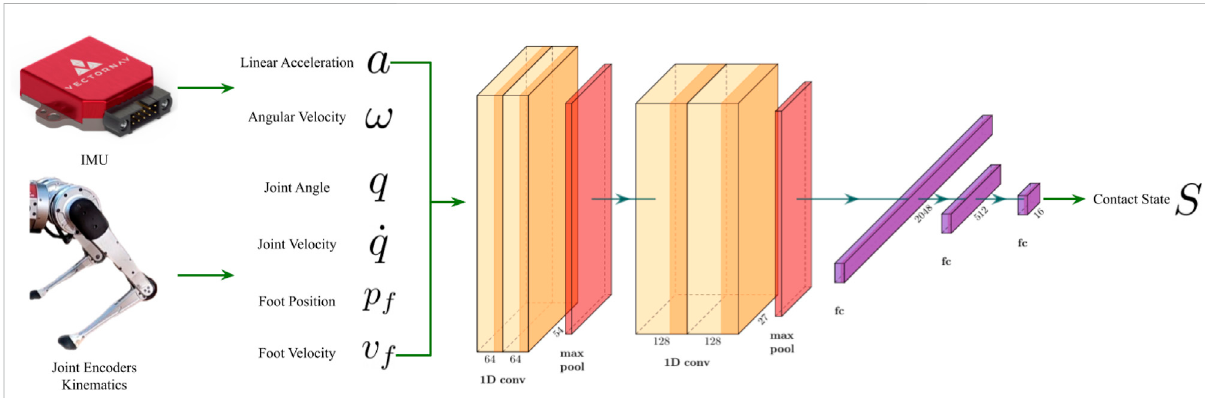
FIGURE 4 Thearchitectureoftheproposedcontactestimator(Linetal.,2022).TheinputsincludelinearaccelerationsandangularvelocitiesfromanIMU, joint angles and joint velocities from encoders, and foot positions and velocities from